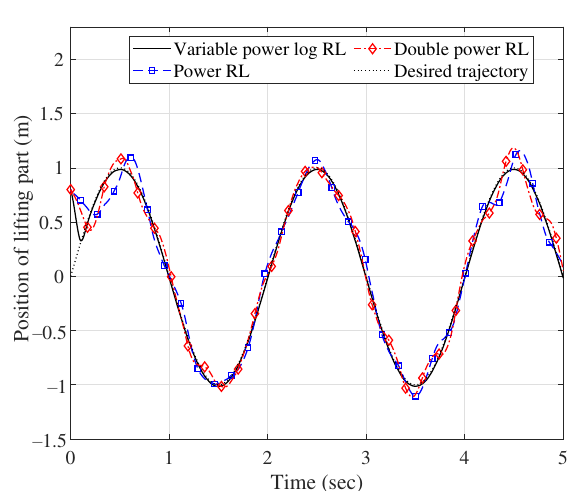
Figure 11. Angular velocity of rotating part (Group 1). Group 2: The simulation results of Group 2 are in Figures 12–15.